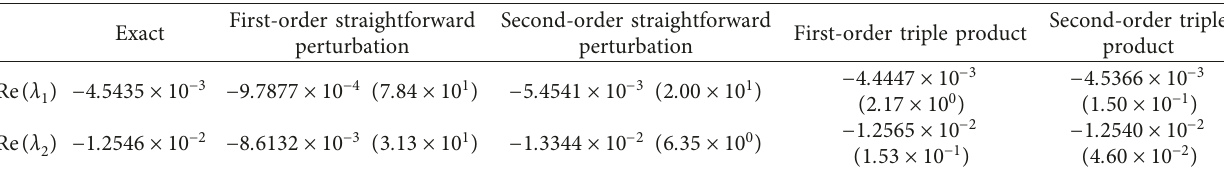
Figure 7: The imaginary parts of the exact and approximate eigenvalues of the two-degree-of-freedom gyroscopic system as a function of σ . Table 3: The real parts of the exact and approximate natural frequencies for the perturbed two-degree-of-freedom gyroscopic system of Figure 5 for σ � 0 . 8.